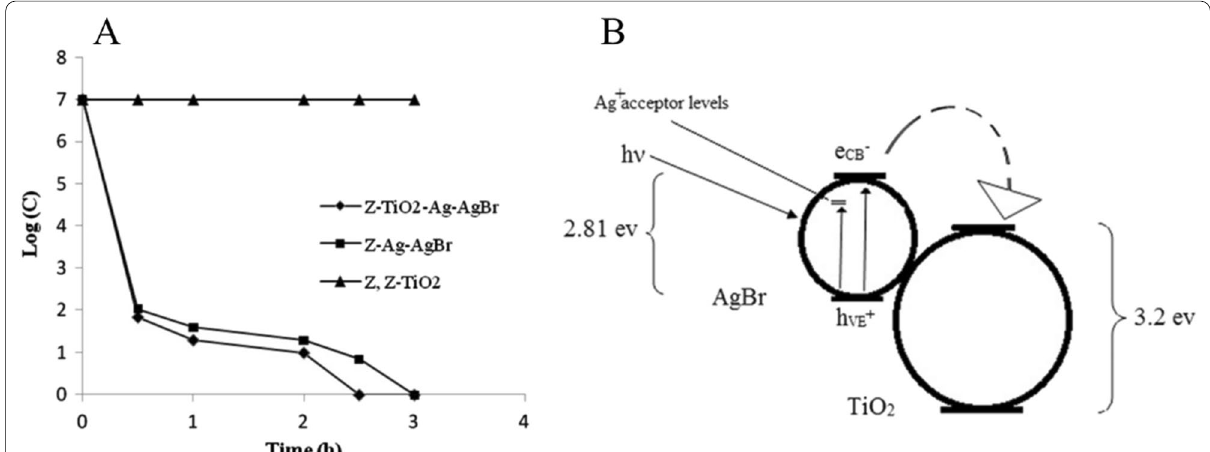
Fig. 10 A E. coli inactivation curve over the composites at the visible light (C 0 conduction band to the lower position TiO 2 conduction band and delay the electron–hole recombination. Adapted from Ref. [9] with permission. Copyright (2012) Materials Science in Semiconductor